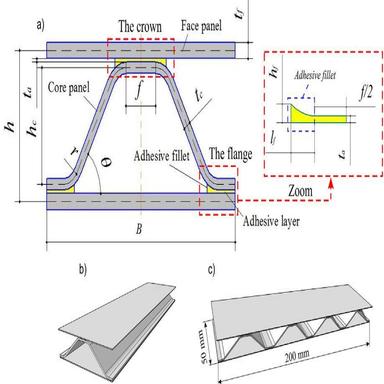
Schematics of the ABCSS: a) Unit cell of ABCSS; b) Longitudinal and c) Transverse loading directions of ABCSS.